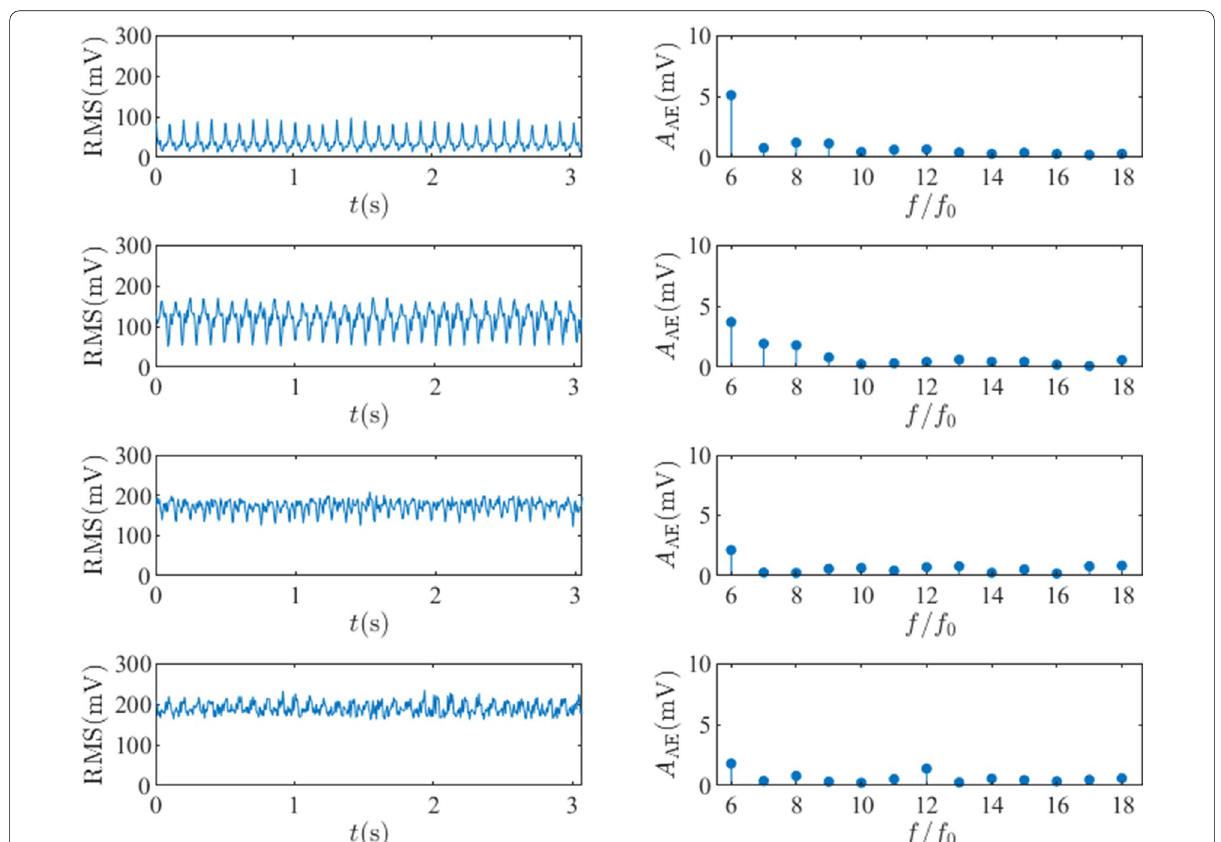
Figure 13 RMS fluctuations and their oscillation components observed in